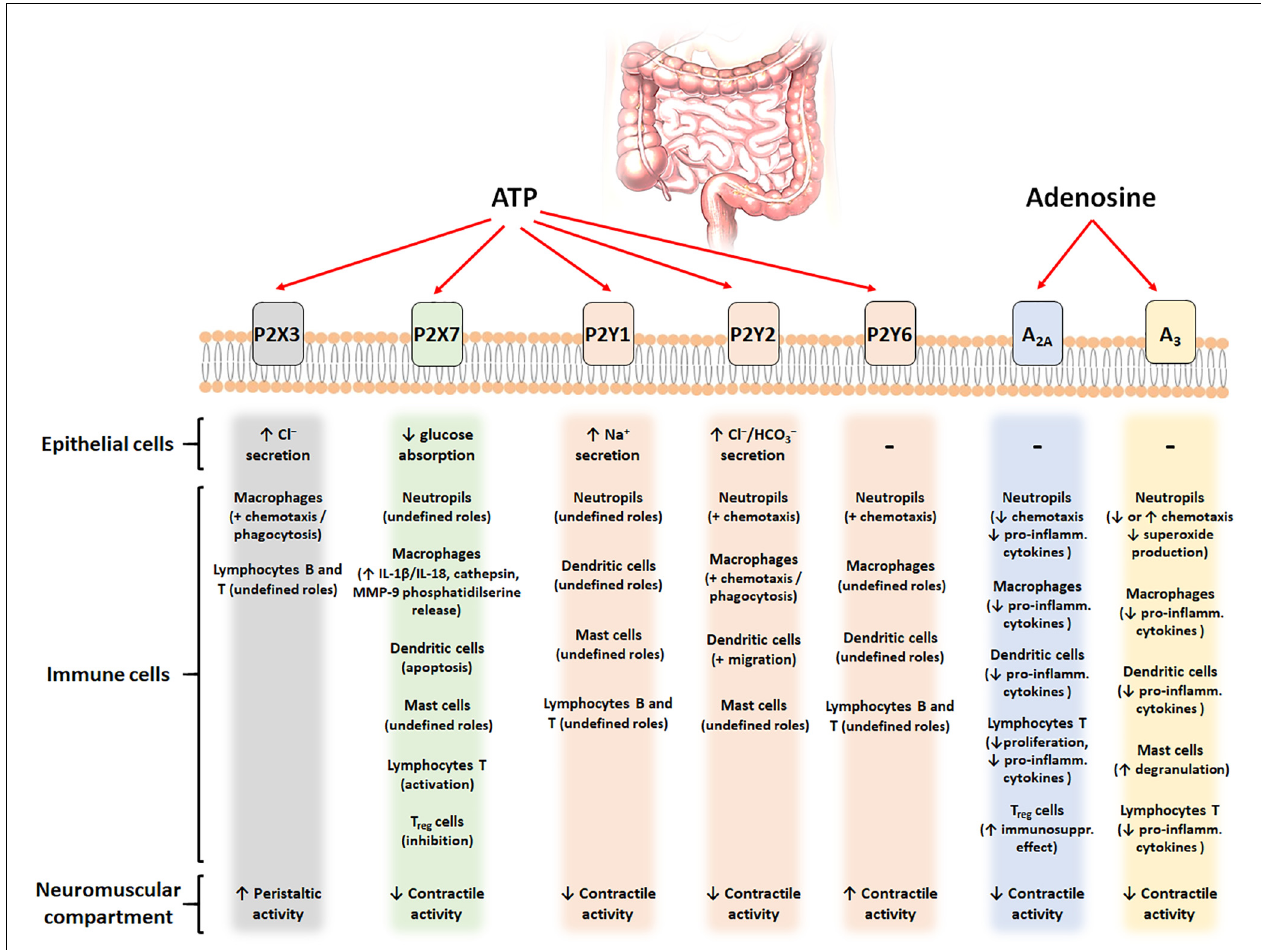
FIGURE 1 | Schematic figure with the putative contribution of the main purinergic signals (ATP and adenosine) and their different receptors (P2X3, P2X7, P2Y 1 , 2 , 6 , A 2A , and A 3 ) in different cell types of the intestinal